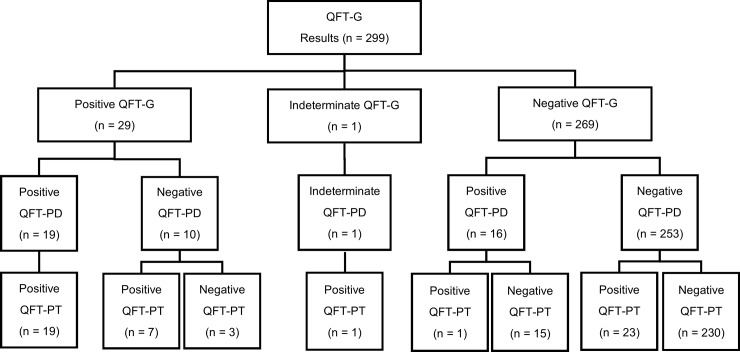
Flowchart of results from QFT-G, QFT-PD, and QFT-PT assay.